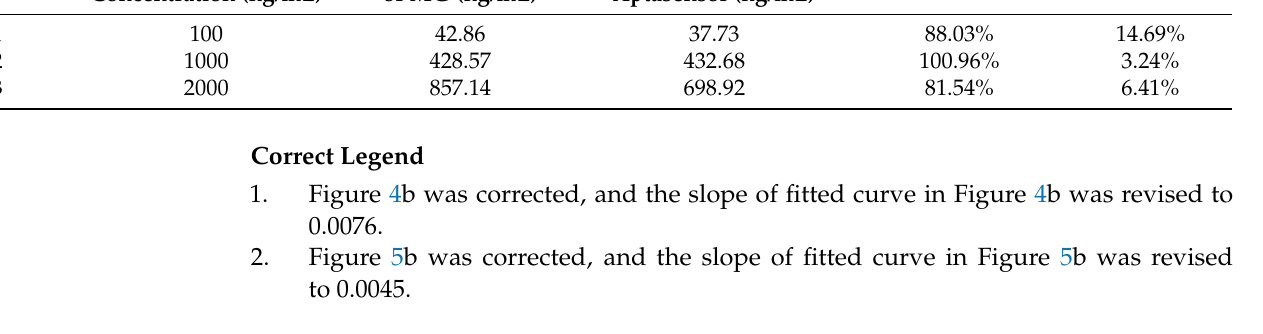
2 of 6 Figure 4. GO concentration optimization and sensitivity test of aptamer MG-36-12 in GO-based flu- orescent aptasensor. ( a ) GO concentration for the fluorescence quenching of FAM-labeled aptamer,